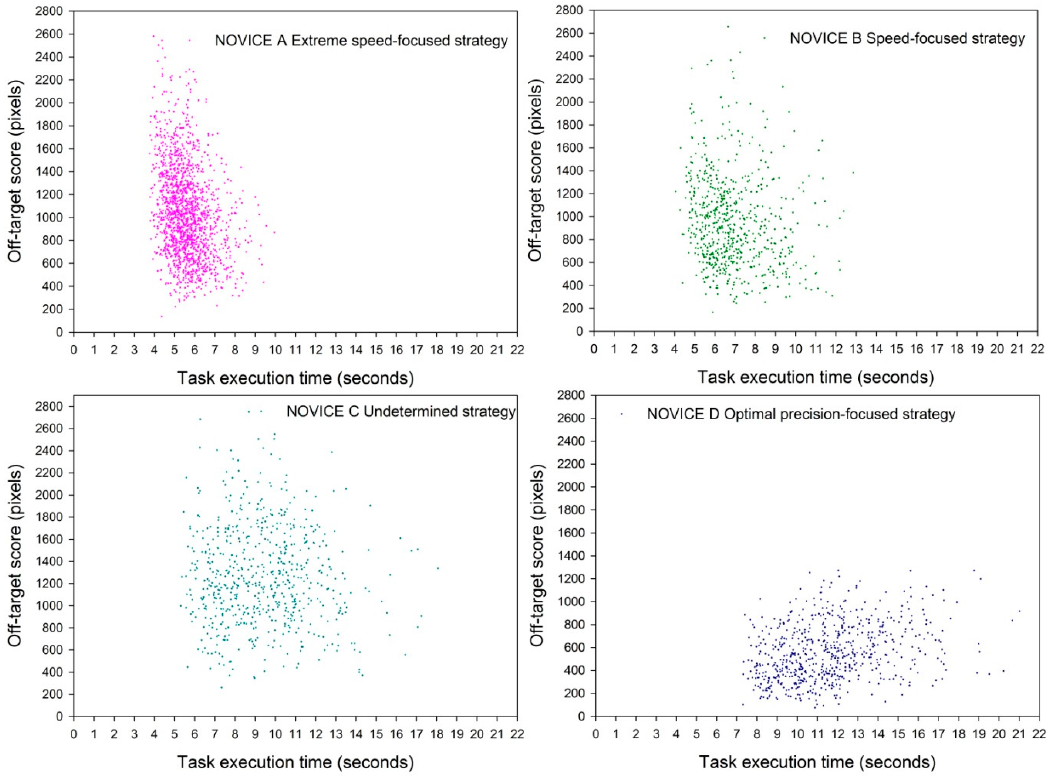
Figure 2. Individual trade-off functions between task execution times, plotted in ascending order, and their corresponding off-target scores (precision measure) for four novices who trained in a large number of sessions across 2D camera view conditions. The data reveal four different training strategies.